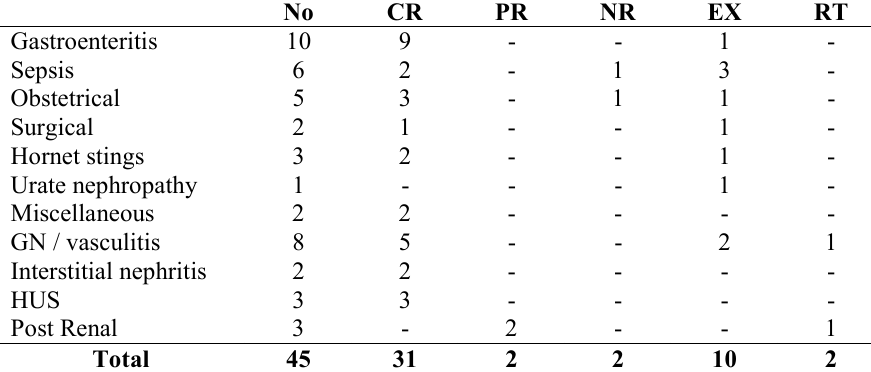
Table I: Aetiology and outcome of ARF